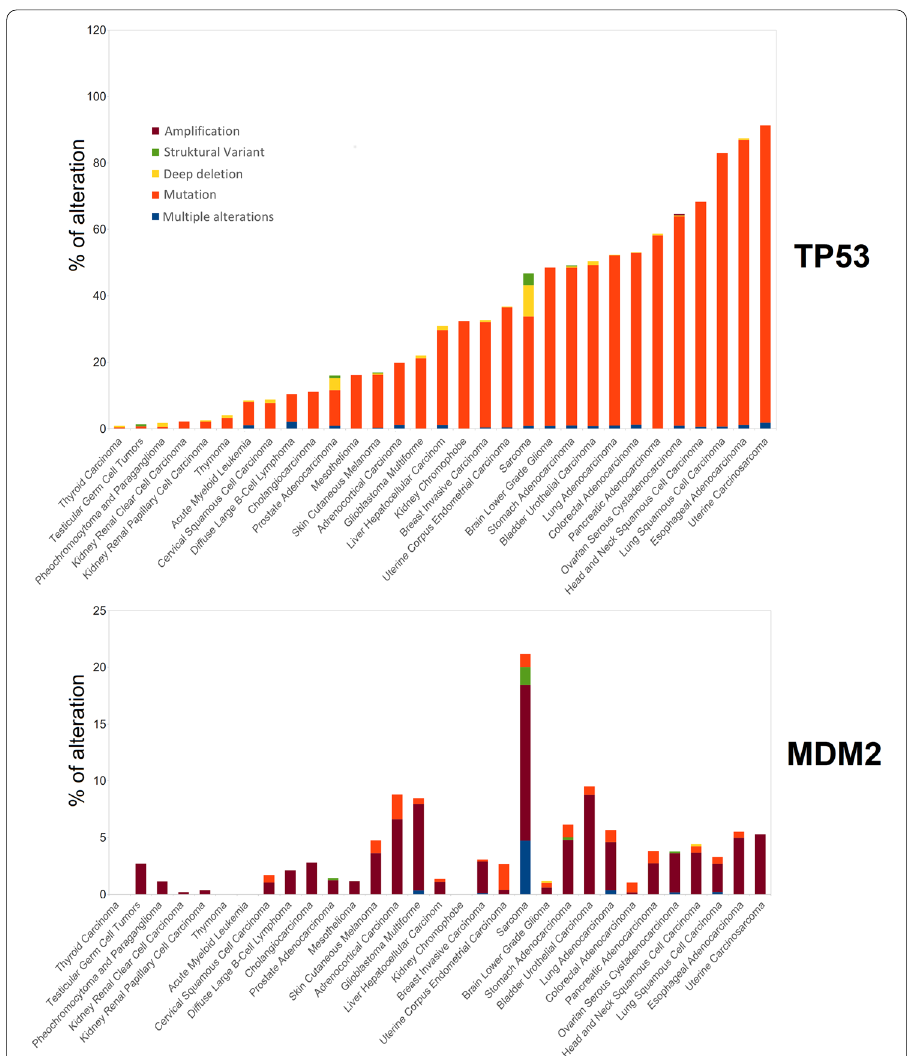
Fig. 2 Cancer‑associated alteration in TP53 and MDM2. The distribution of alterations in TP53 and MDM2 genes divided by cancer type (colour coding: deep red amplification, green structural variation, = = yellow deep deletion, red mutation, dark blue multiple alterations). The cancer types are ordered from = = = lowest to highest percent of TP53 alterations. The data were obtained from TCGA